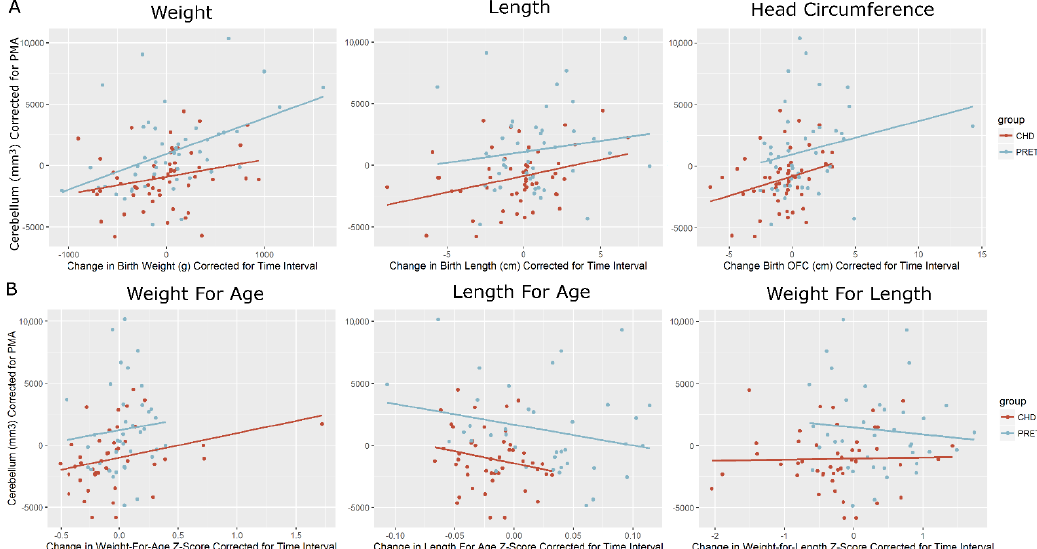
Figure 2. Cerebellar volumes (corrected for PMA) correlated with growth parameters at time of MRI. ( A ) Raw measurements and ( B ) z-Scores Growth parameters were converted to normative Z-scores following WHO guidelines, and normalized for time interval (zMRI-zBirth/ Δ time). Volumes were corrected for post-menstrual age (PMA). Change in weight from birth to time of MRI showed a moderately strong correlation with cerebellar volume at time of MRI (r = 0.437, p < 0.002) in the preterms, but not the in the term-born CHD neonates (r = 0.205, p < 0.116), significant at p < 0.000. Changes in both the birth length and occipital-frontal circumference (from birth to time of MRI) showed a moderate (but not significant) correlation with cerebellar volume at the time of MRI in both cohorts. When normalized to Z-scores, no correlation is observed.